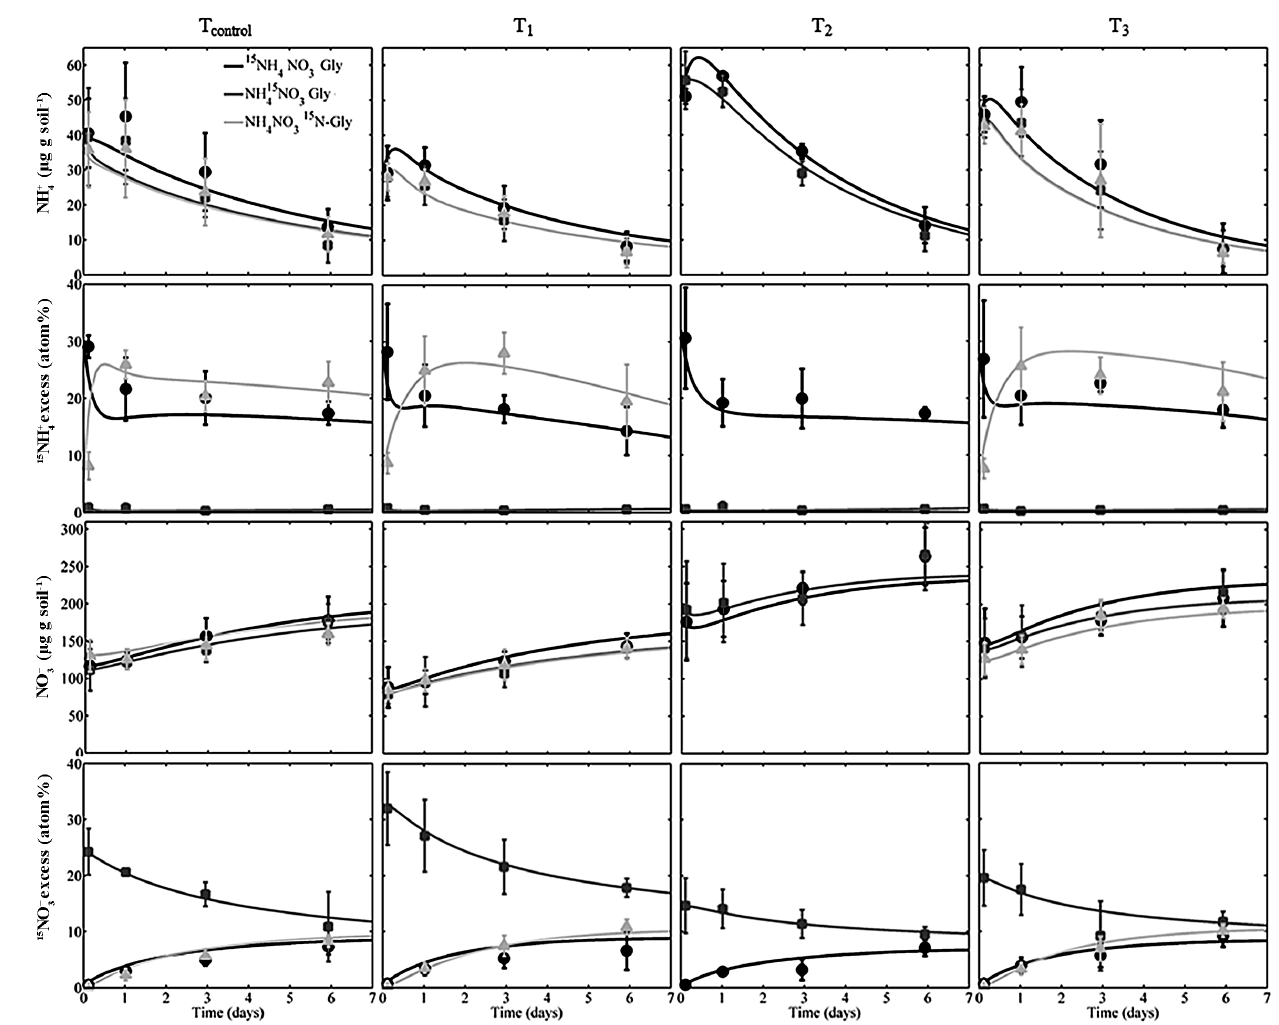
Figure 4. Modelled vs. measured data. The lines are modelled data, and the squares, circles and triangles are the measured data points. Error bars are standard deviations. Time is the time in days from the moment of label